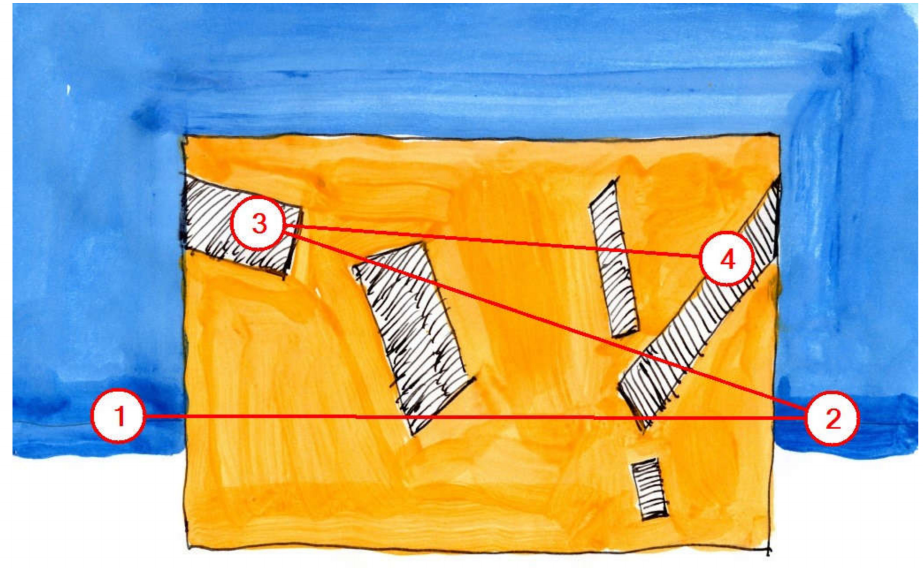
Figure 9. Scanning sequence for contemporary building with diagonal slit